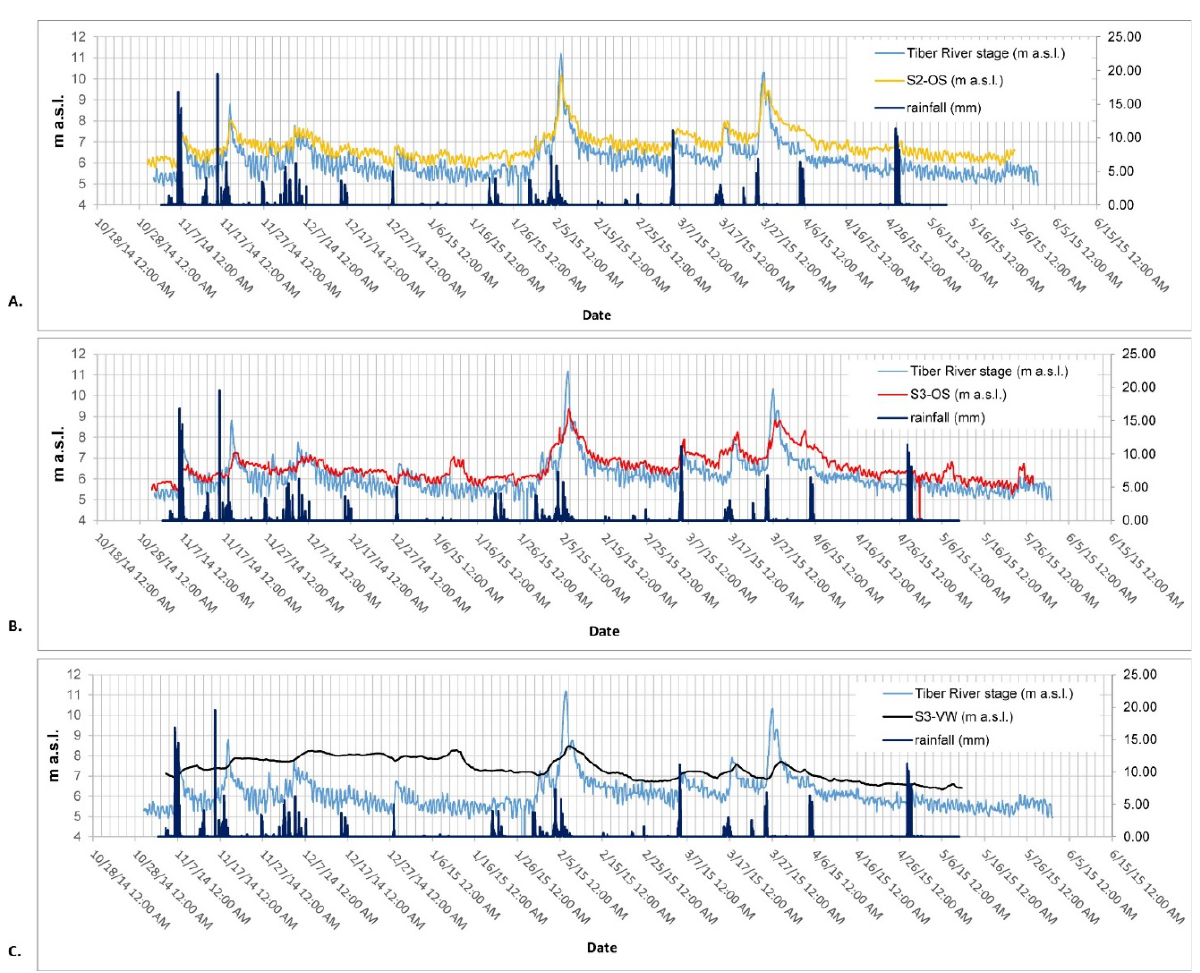
Figure 10. Recorded head level and comparison with rainfall and Tiber stage in Open Standpipe piezometers S2 ( A ), Open Standpipe S3 ( B ), and Vibrating wire S3 ( C ).